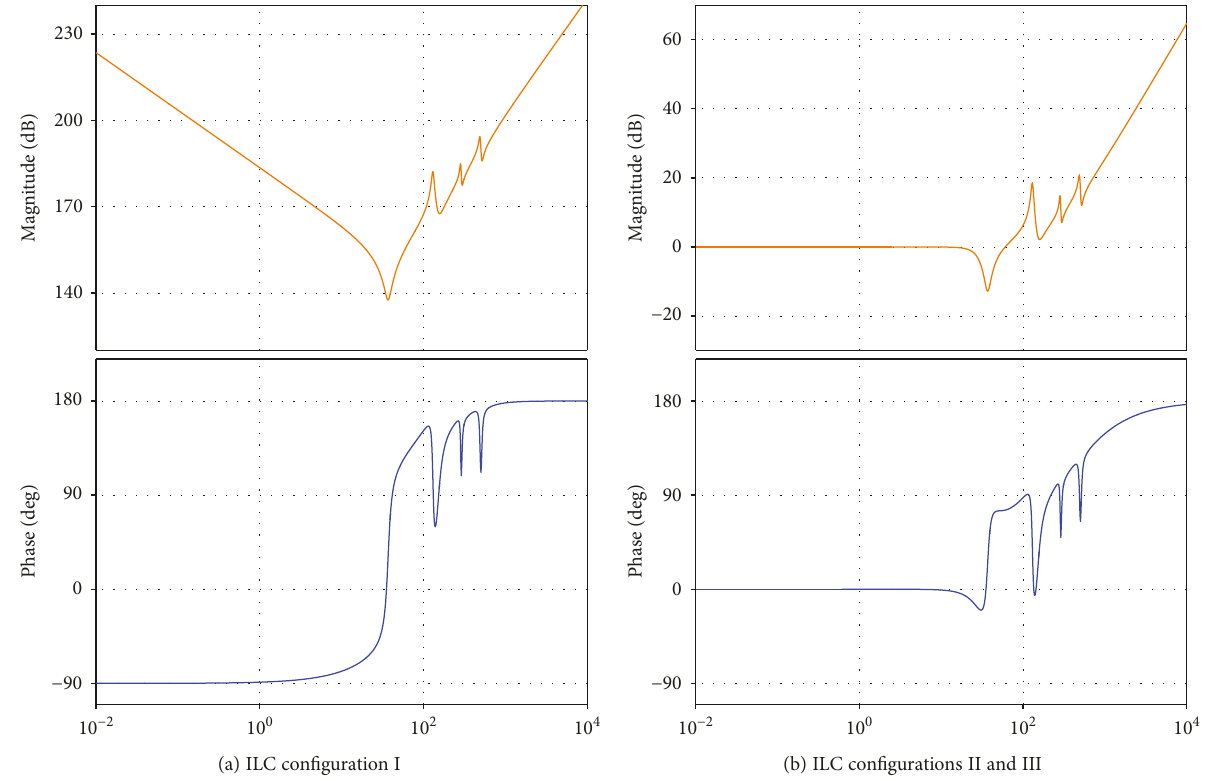
Figure 5: Frequency responses of ideal learning fi lters for ILC con fi gurations I, II, and